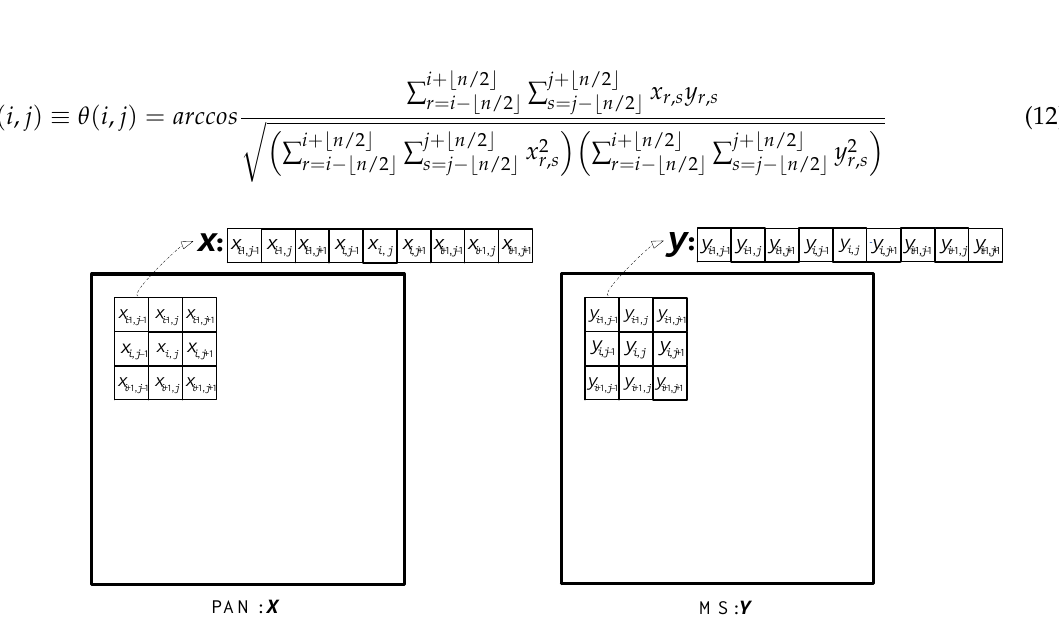
Figure 4. 3 × 3 adjacent region elements vector diagram.